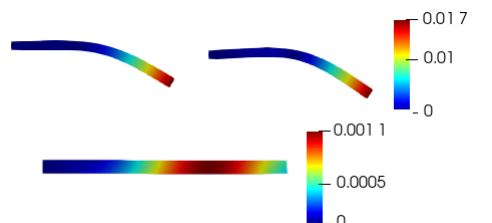
Figure 8. The deformation of the bar at time t = 0.9 s: the FE solution ( top left ) and the reduced order solution ( top right ). Bottom: approximation error | d s , h − d s , N | , represented over the solid reference = 21 basis functions were used for the solid displacement. configuration (undeformed state). N d s The deformation was magnified by a factor 5 for visualization purposes.